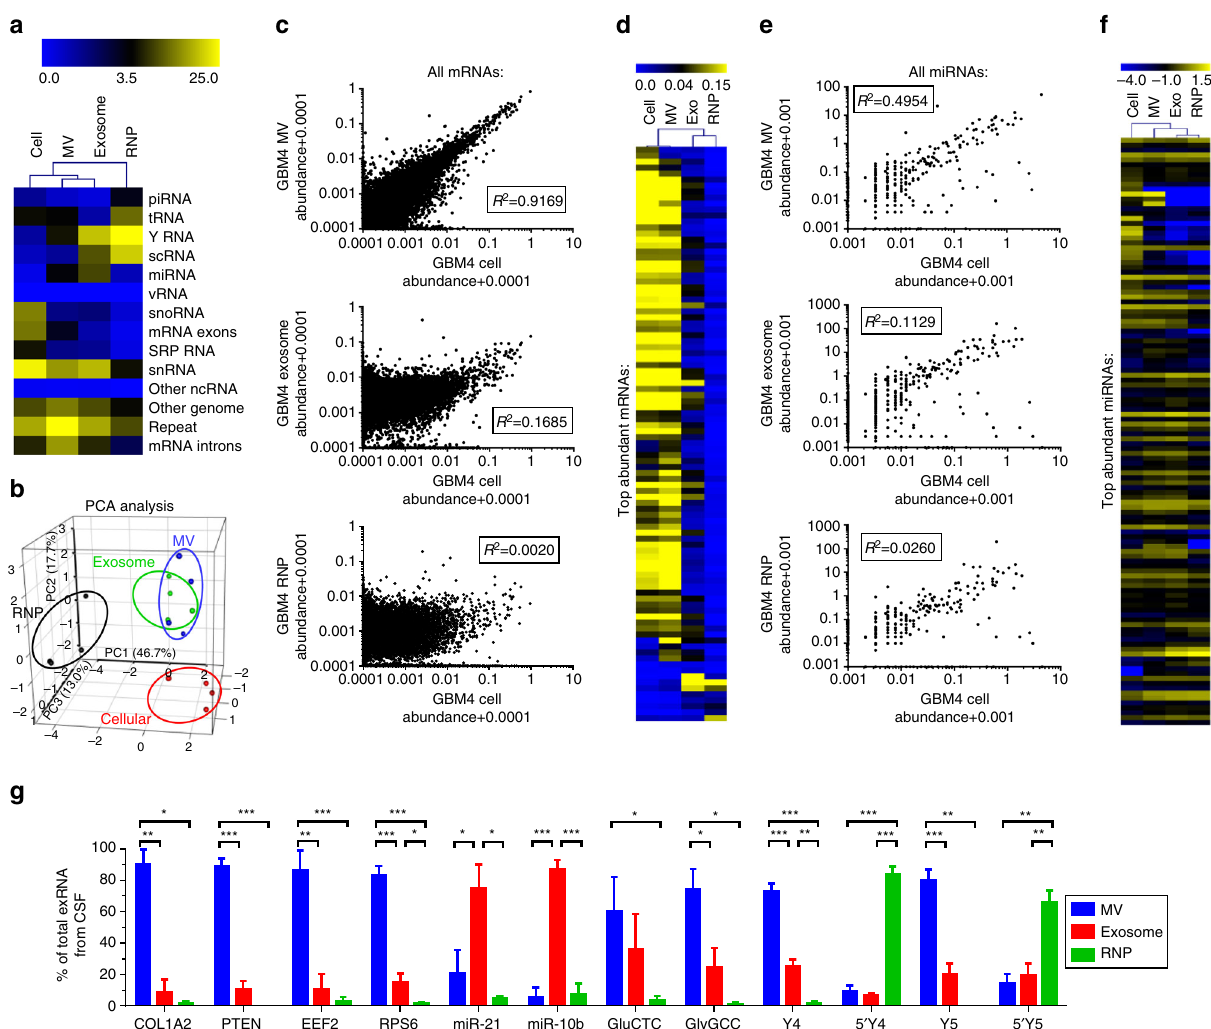
Fig. 7 RNA repertoire of MV most closely re fl ects cellular RNA composition. a Heat map cluster analysis of RNA classes indicates relative similarity of the composition of MVs and the source cells. The scale bar represents the percentage of non-rRNA annotated reads. b PCA analysis of RNA classes. Different fractions are marked in different colors. Within each fraction, four dots represent four GSC cultures. c , d GBM4 MV represents the cellular mRNA content closely, and much better than exosomes or RNPs, based on the correlation analysis of all mRNA species ( c ), and cluster analysis of the top abundant mRNAs ( d ). The scale bar represents mRNA abundance. e , f Extracellular miRNA composition, in general, is less re fl ective of the cellular miRNome; nevertheless, MV fraction still remains the best simulator, based on the correlation analysis of all miRNA species ( e ), and cluster analysis of the top abundant miRNAs ( f ). The scale bar represents the log-transformed miRNA abundance. Similar analyses of other cell cultures can be found in Supplementary Figs. 14 – 17. g qRT-PCR analysis of exRNA fractions isolated from the CSF of GBM patients, using the same fi ltration-based procedure, indicates its applicability to clinical samples. The data verify preferential association of selected RNA species with different exRNA fractions in the human bio fl uid ( n = 4 CSF samples). All bars represent mean ± SEM. *, p < 0.05; **, p < 0.01; ***, p < 0.001; t